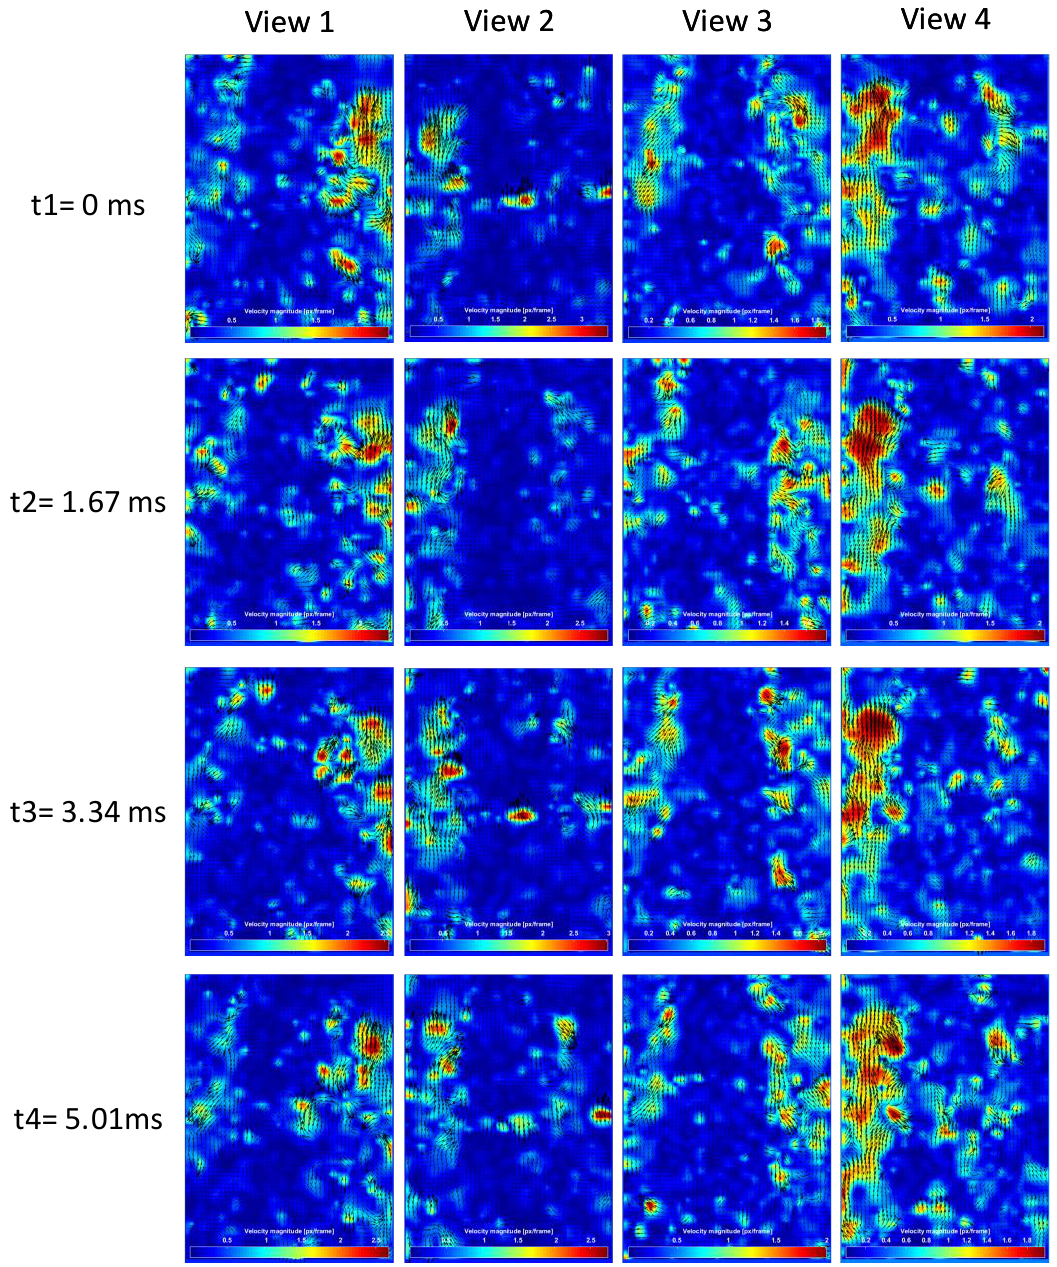
Figure 15. Velocity magnitude drawings of PIV